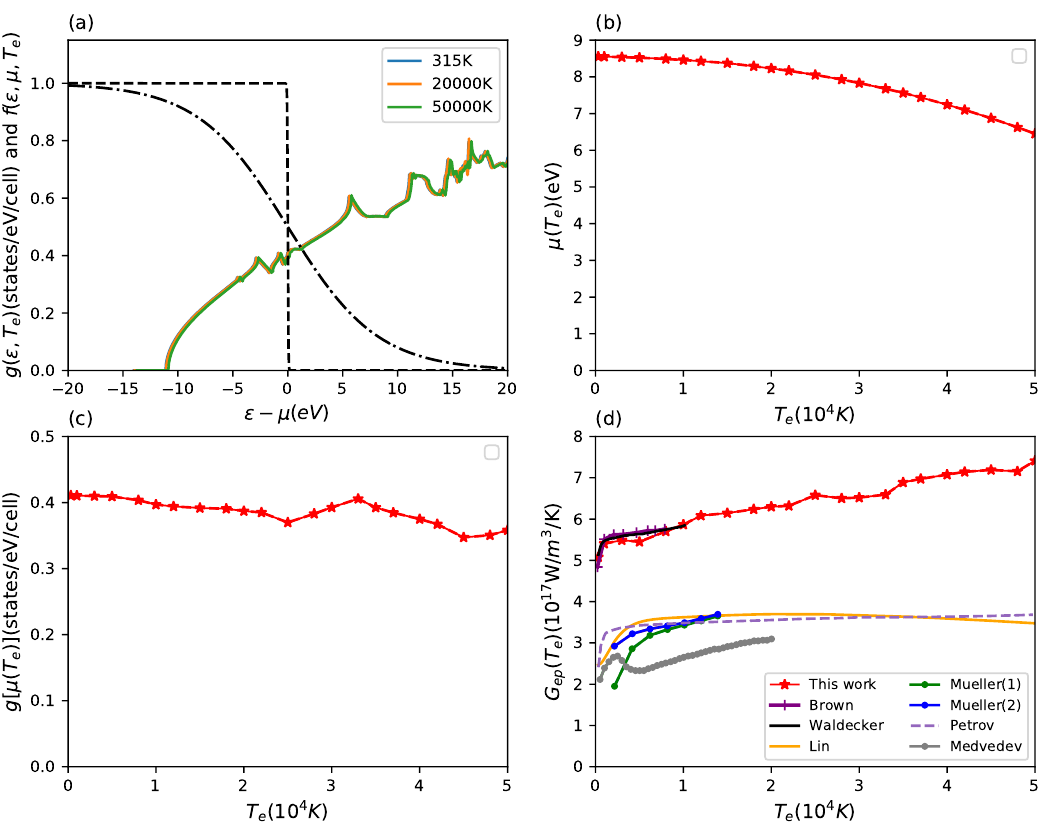
Figure 2. Results for aluminum. ( a ) Electron density of states g ( ε , T e ) with increasing electron temper- ature and Fermi distribution function f ( ε , µ ( T e ) , T e ) (dashed lines) for two electron temperatures at 315 K and 50,000 K; ( b ) chemical potential µ ( T e ) and ( c ) electron density of states at chemical potential g [ µ ( T e )] as a function of electron temperature; ( d ) electron temperature-dependent electron–phonon coupling factor G ep ( T e ) , compared with various theoretical calculations. The available theoretical data are predicted by Lin et al. [44], Müller et al. [45] (their estimations contain two different physical conditions), Petrov et al. [46], Waldecker et al. [33], Brown et al. [48], and Medvedev et al.